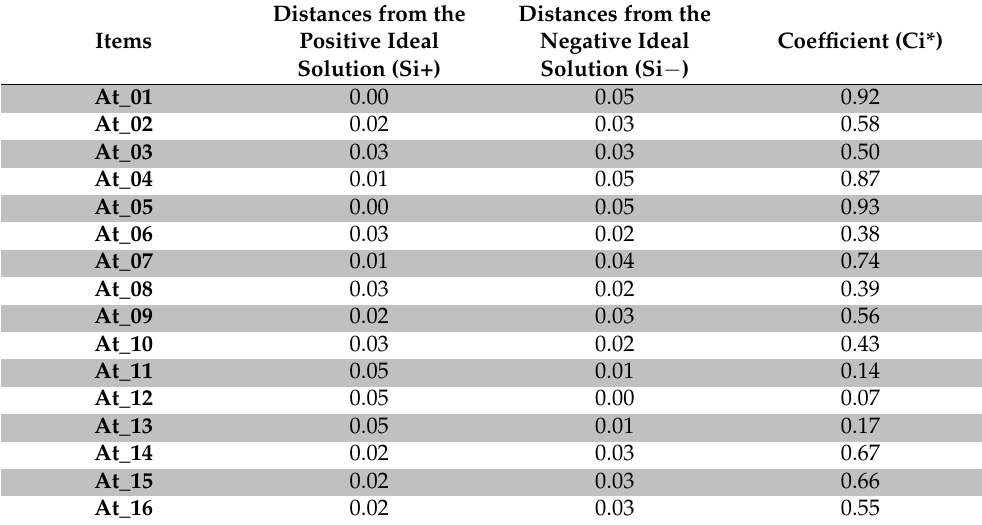
Table 9. Distances from the positive ideal solution, distance from the negative ideal solution, and coefficient Ci*.